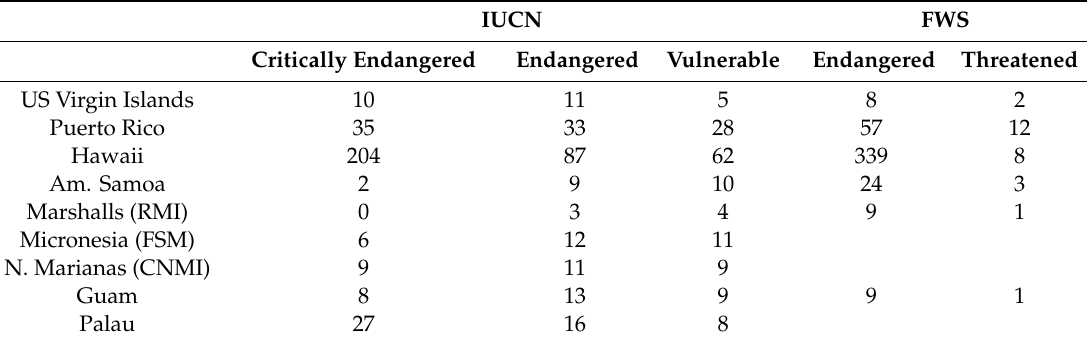
Table 3. At-risk forest associated plant and animal species listed by the International Union for the Conservation of Nature (IUCN) and by the U.S. Fish and Wildlife Service (FWS) in tropical islands of and politically a ffi liated with the U.S. (listed east to west). IUCN FWS Critically Endangered Endangered Vulnerable Endangered Threatened US Virgin Islands 10 11 5 8 2 Puerto Rico 35 33 28 57 12 Hawaii 204 87 62 339 8 Am. Samoa 2 9 10 24 3 Marshalls (RMI) 0 3 4 9 1 Micronesia (FSM) 6 12 11 N. Marianas (CNMI) 9 11 9 Guam 8 13 9 9 1 Palau 27 16